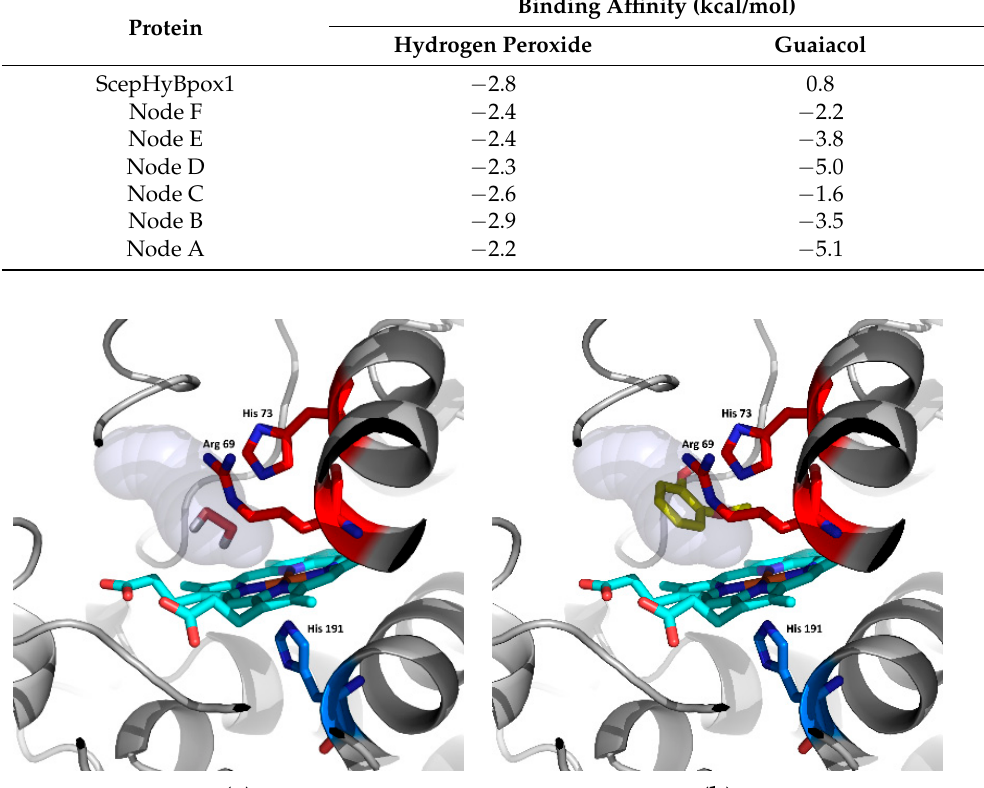
Figure 8. Analysis of potential substrates binding in the active centre of Hybrid B heme peroxidase— the ancestor from node A using AutoDock Vina [28]. ( a ) Docking of hydrogen peroxide and ( b ) dock- ing of guaiacol, cyan—prosthetic heme